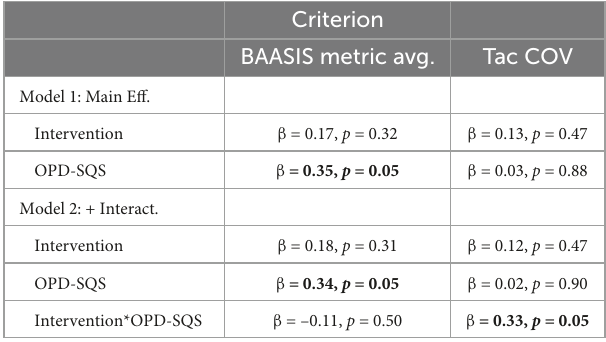
TABLE 4 Interaction tests.